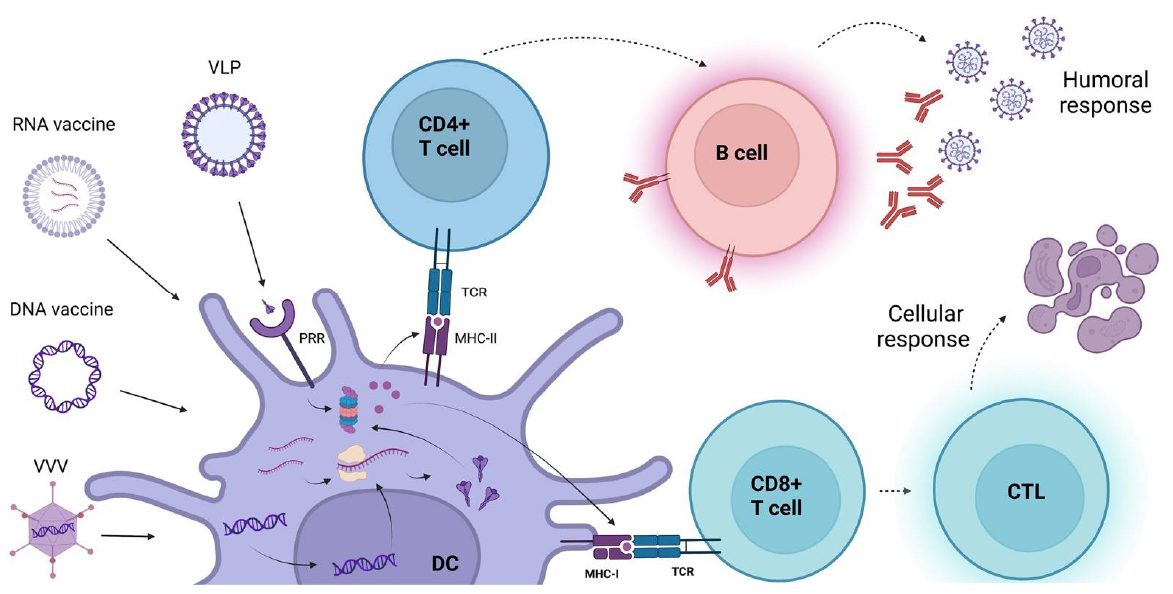
Figure 3. Immune activation induced by nanovaccines. VLP, virus-like particles; VVV, viral vector vaccine; DC, dendritic cells; PRR, pattern recognition receptor; MHC, major histocompatibility complex; TCR, toll-like receptor.